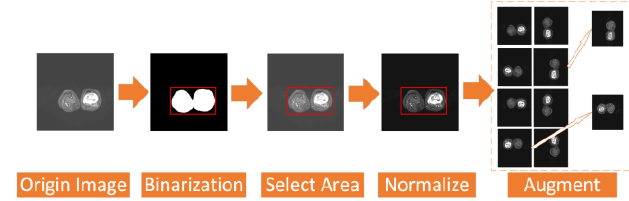
Figure 2. Process of data preprocess.